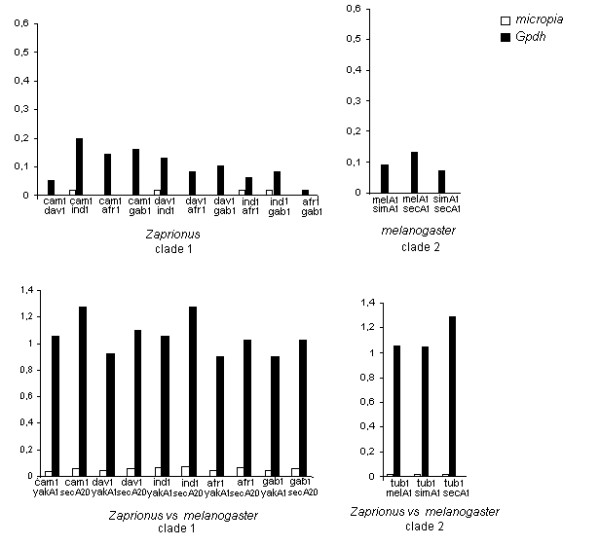
Comparative analysis of dS values of Micropia and Gpdh. Comparative analyses of the dS values between Micropia and Gpdh of Zaprionus and melanogaster species. Comparison with only black column indicates that the synonymous sites of Micropia are invariable. tub: Z. tuberculatus, cam: Z. camerounensis, dav: Z. davidi, gab: Z. gabonicus, afr: Z. africanus, ind: Z. indianus, mel: D. melanogaster, sim: D. simulans, sec: D. sechellia, yak: D. yakuba.